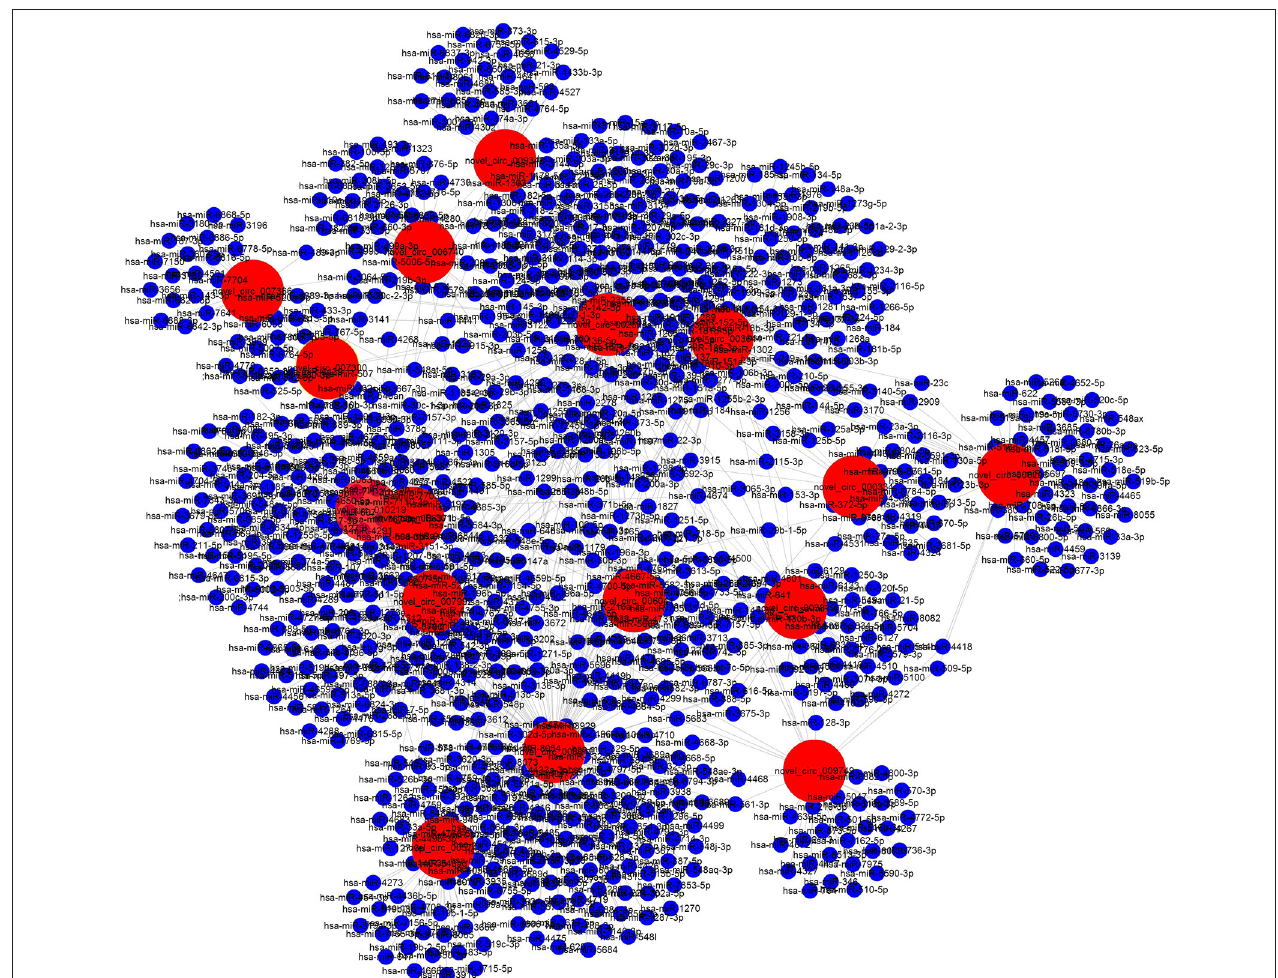
FIGURE 9 | The dysregulated circRNA/miRNA network analysis.